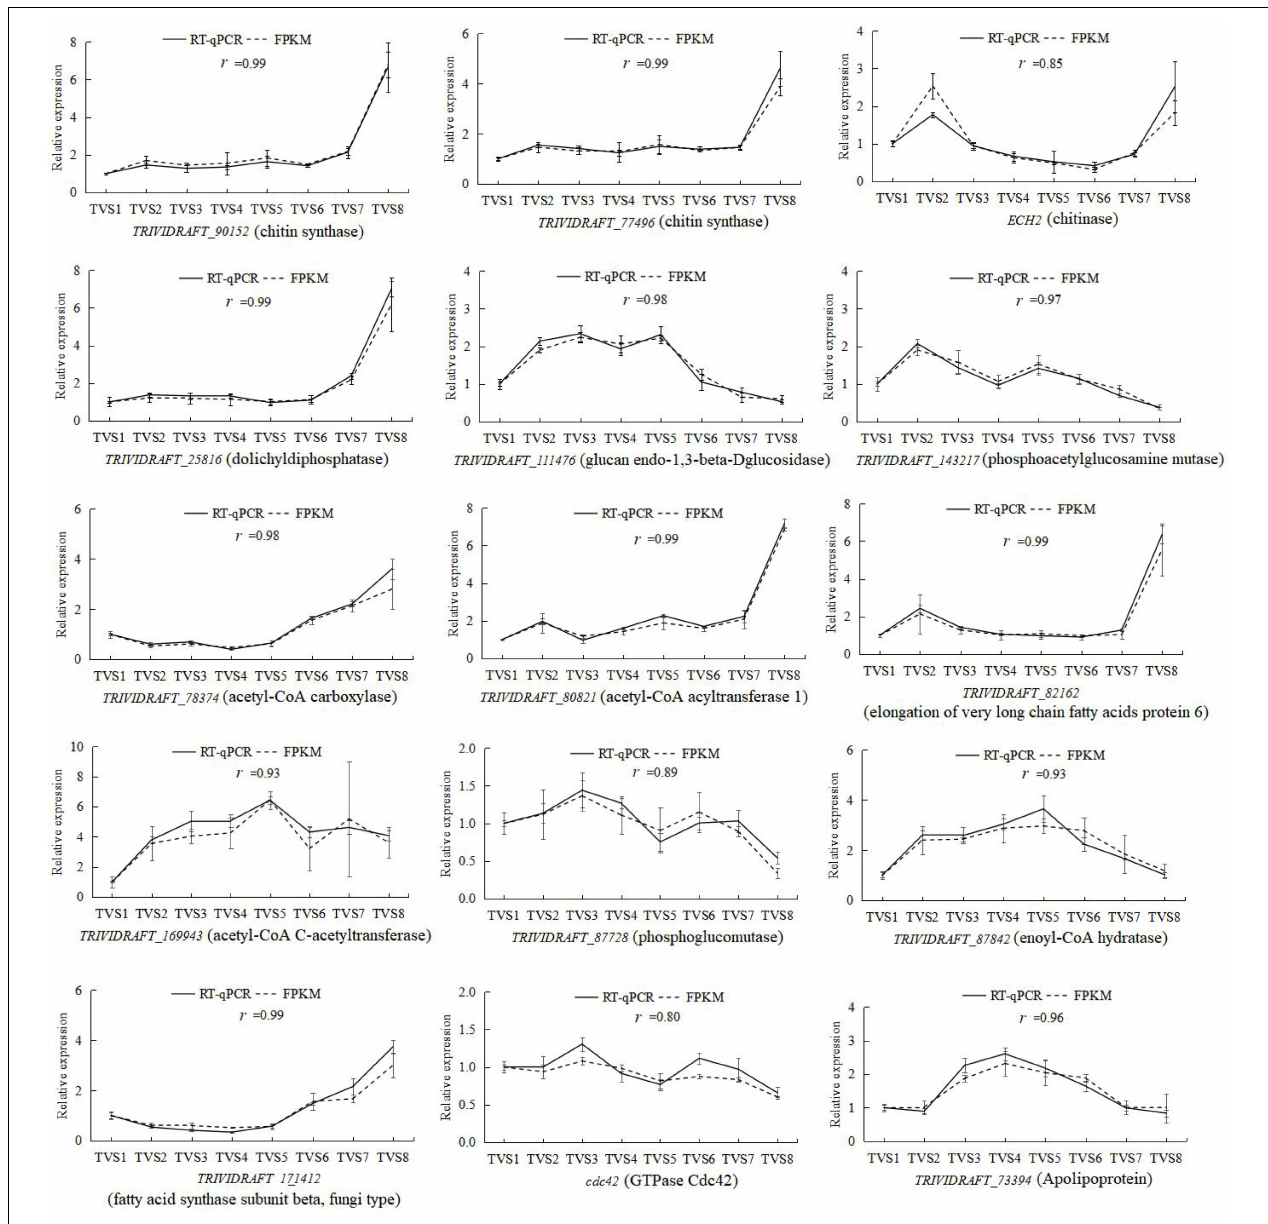
FIGURE 9 | RT-qPCR determination of the expression levels of 15 selected DEGs during CF in T. virens GV29-8. The vertical axis represents the relative expression levels of DEGs across 8 sampling time points. The horizontal axis indicates the sampling time. Error bars represent the standard deviation of three independent replicates for each tested gene. The value r represents the correlation between RT-qPCR and RNA-seq